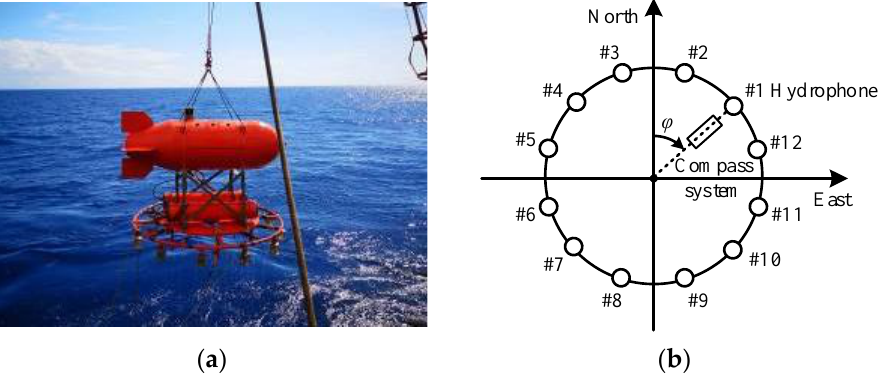
Figure 6. Configuration of the underwater buoy system: ( a ) photo of the underwater buoy system; ( b ) configuration of the UCA and the compass system.